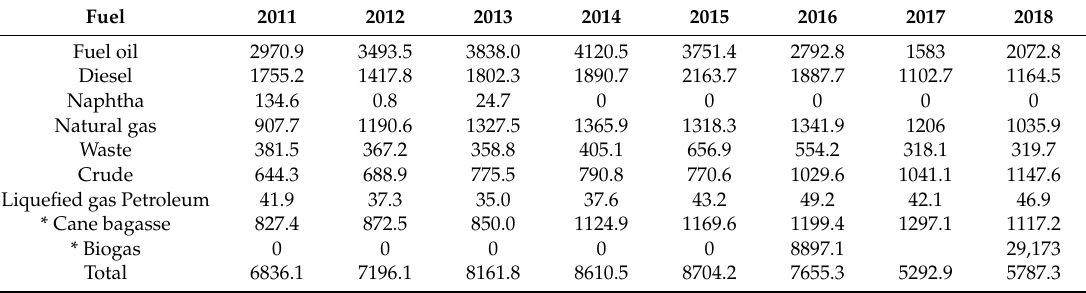
Table 5. CO 2 emissions (kt · year − 1 ) due to gross electricity generation in Ecuador.